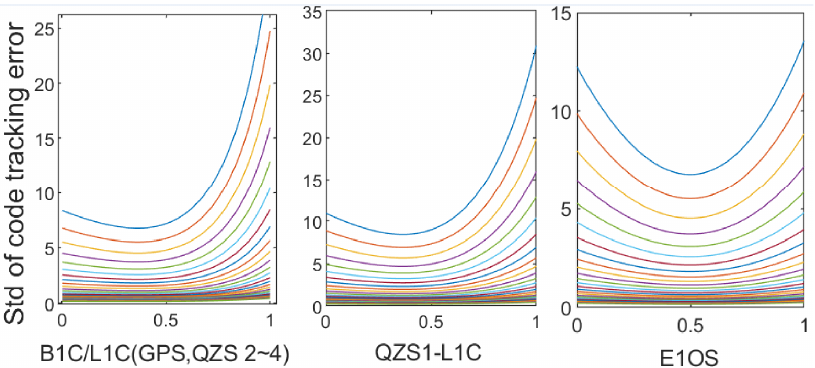
Figure 4. The std of code tracking error for the correlator joint (different colors represent different C/N0 conditions (25–50 dB)).